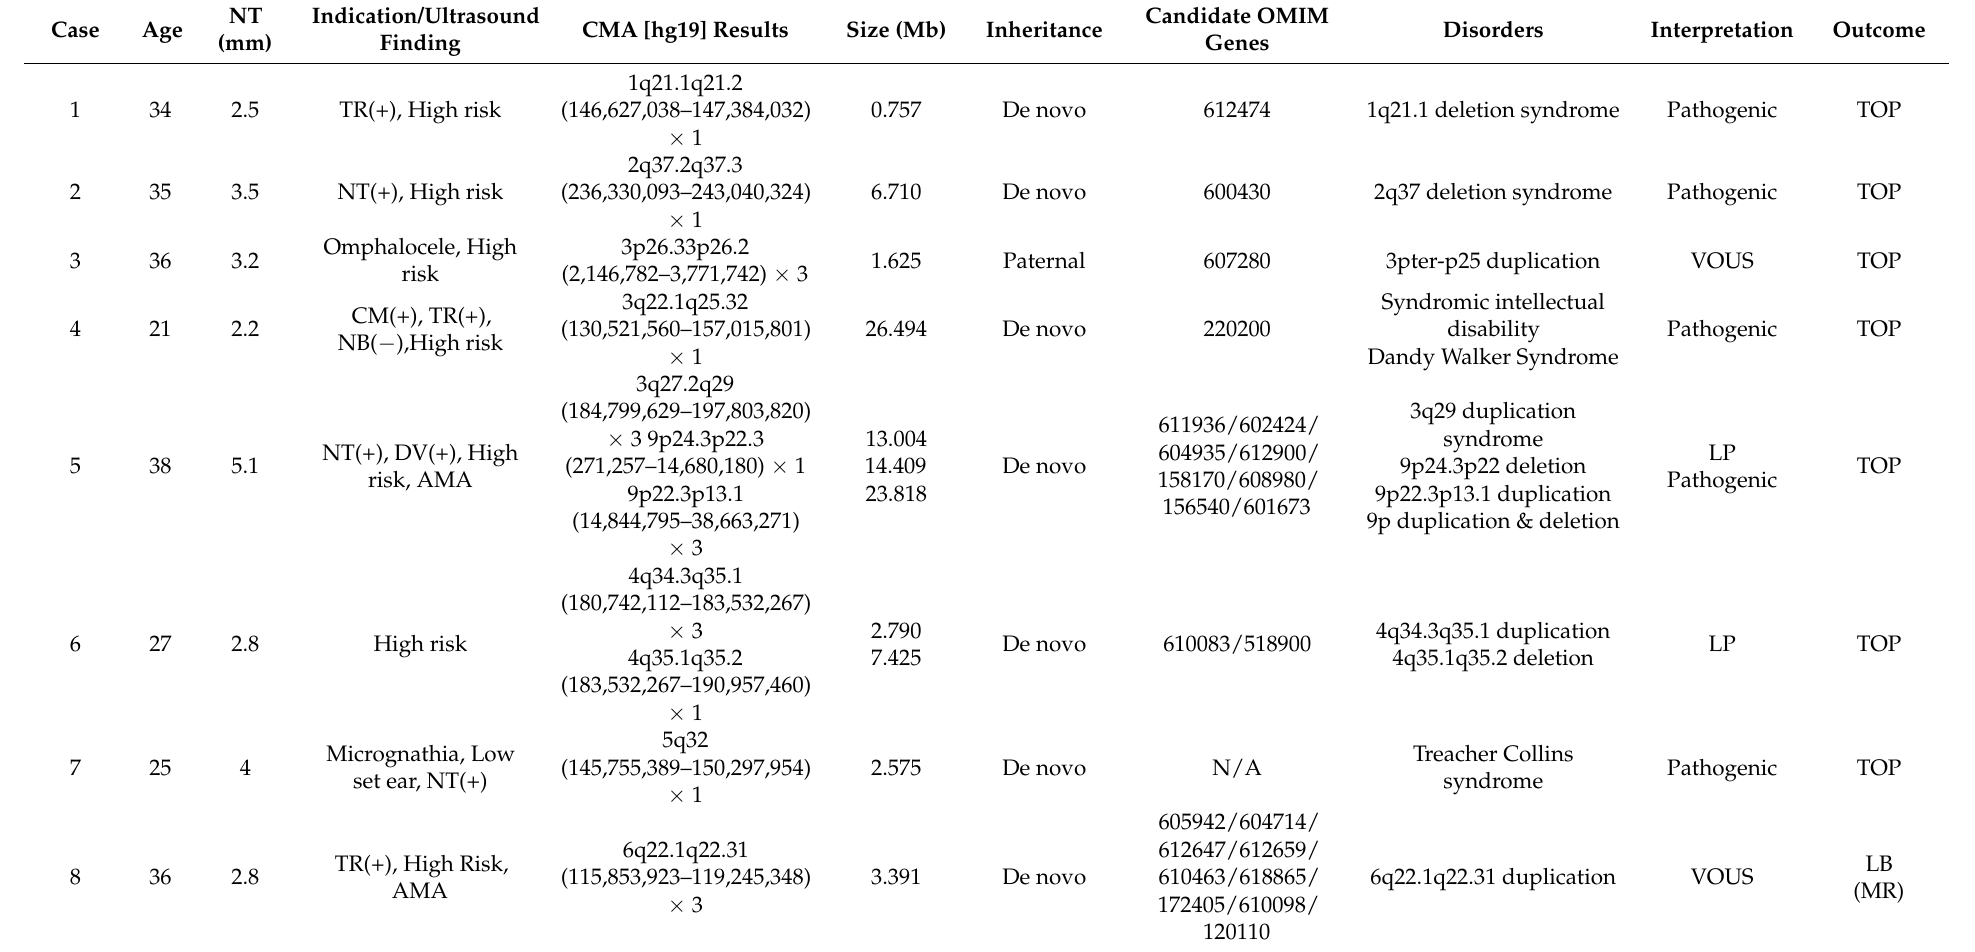
Table 2. Overview of the pathologic, likely pathologic, and susceptibility copy number variants reported after chromosome microarray analysis of pregnancies in this